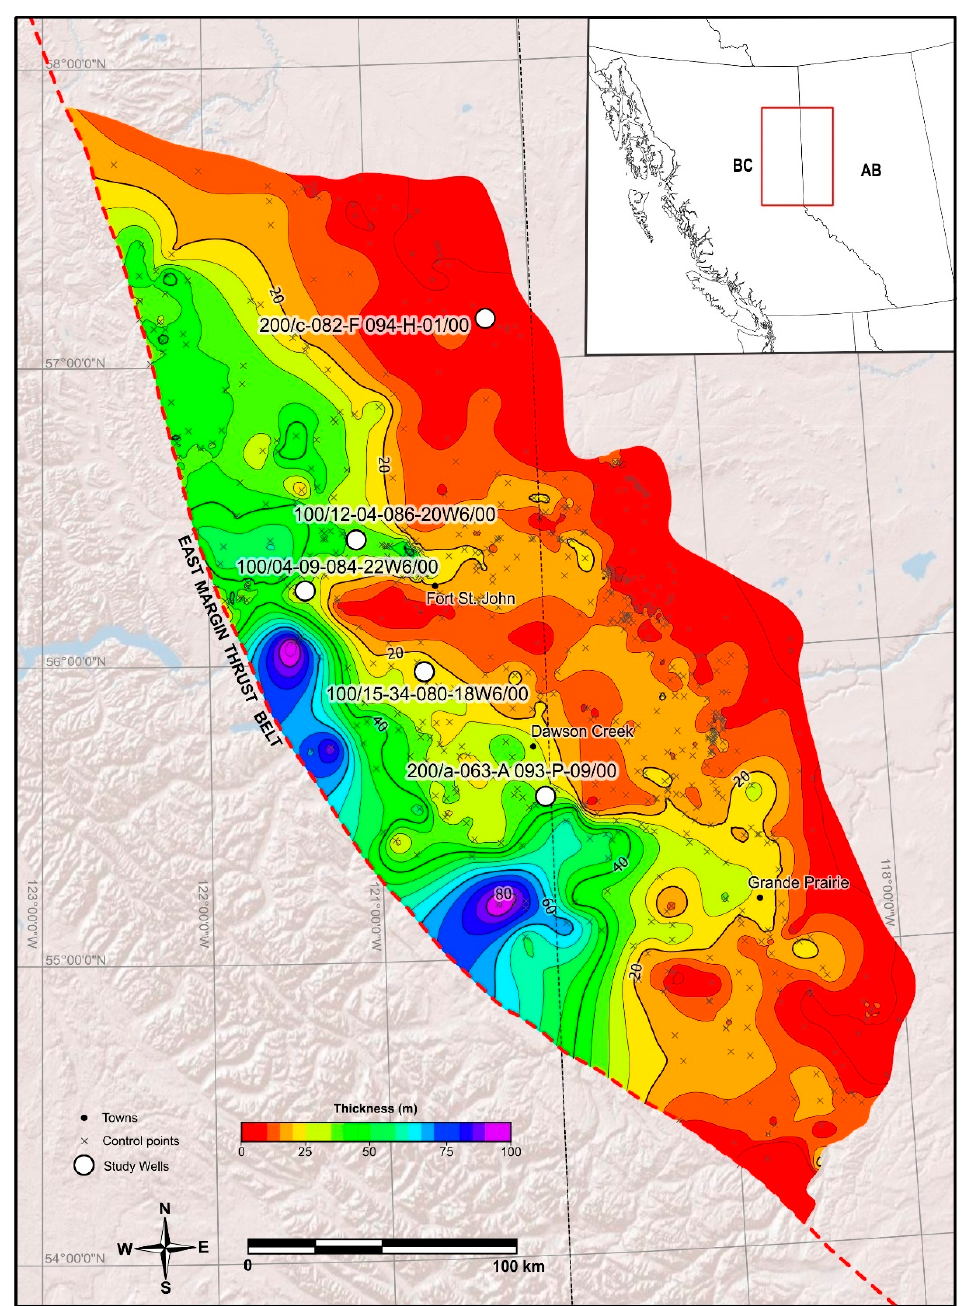
Figure 2. Isopach map of the Doig Phosphate Zone with thickness expressed in meters, location of well control points, and shaded relief topographic backdrop map.